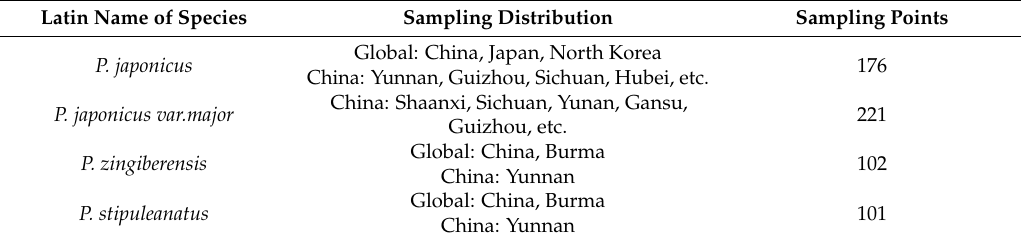
Table 1. Global spatial distribution of sample points for four endangered Panax